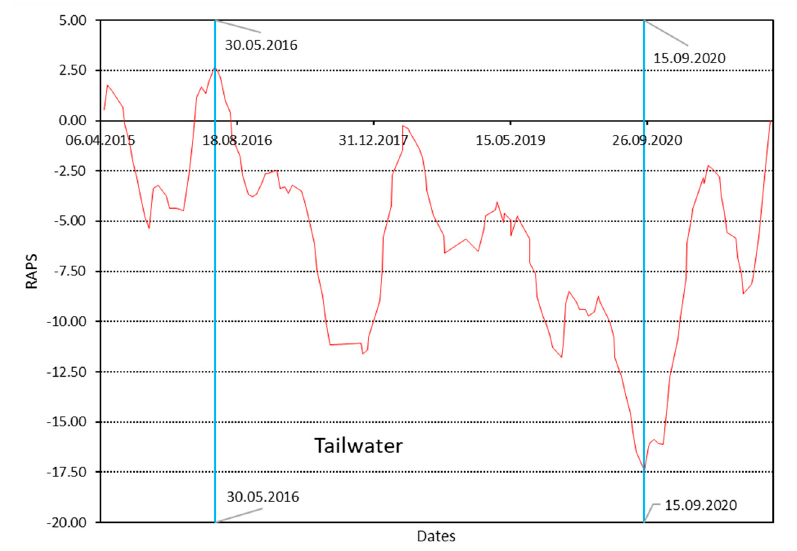
Figure 19. RAPS values for the tailwater of HEPP Mostar.